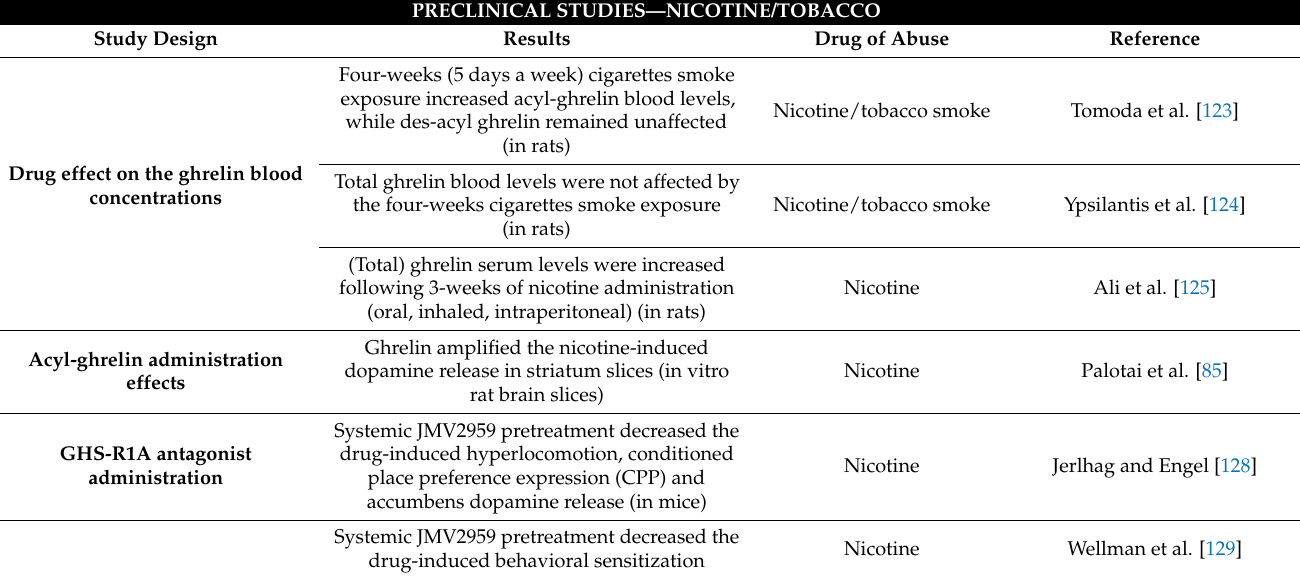
Table 1. Ghrelin/GHS-R1As and nicotine/tobacco—preclinical and clinical studies